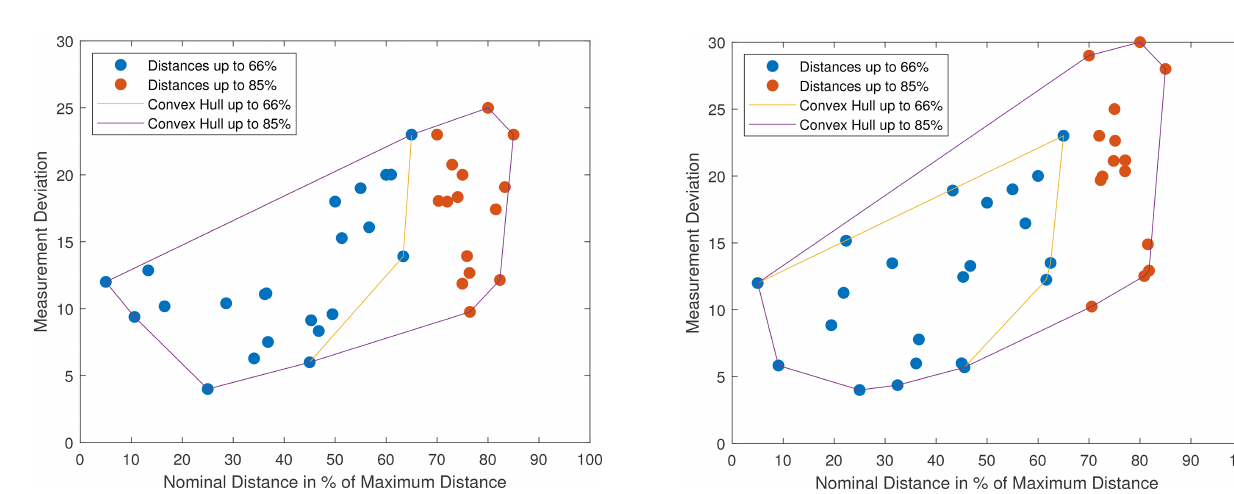
Figure 9. A scenario in which the convex hulls of the measurement points below 66% and of all measurement points (including above 66%) do not agree below 66%. There are points above 66% whose increase in measurement deviation is stronger than linear, and thus we think that in this case, an MPE specification for both point sets (up until 66% and all points) could reasonably be different. A MPE specification for below 66% might not hold for the points above. Such an extreme scenario as depicted here could not be observed in any simulation of this